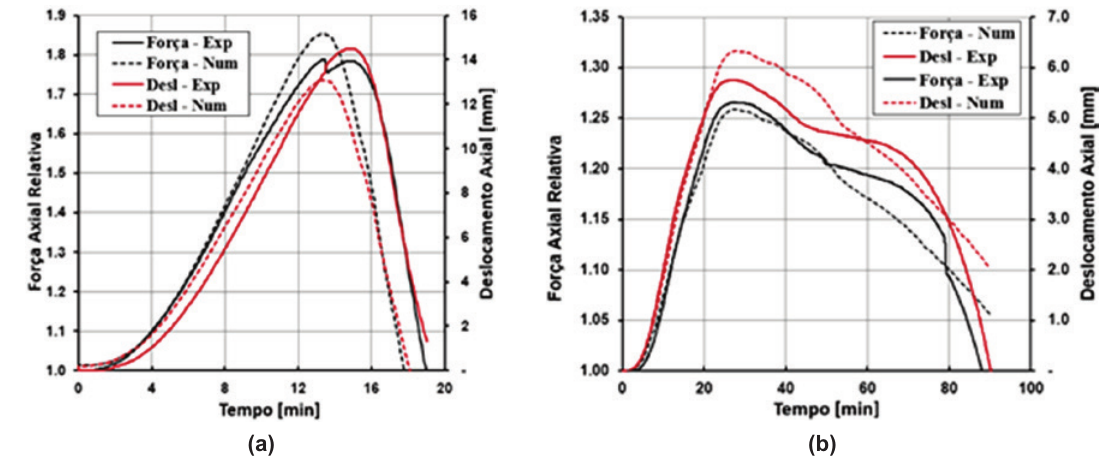
Comparação entre os resultados numéricos e experimentais para as forças axiais relativas e deslocamentos axiais no pilar metálico (a) e misto de aço e concreto